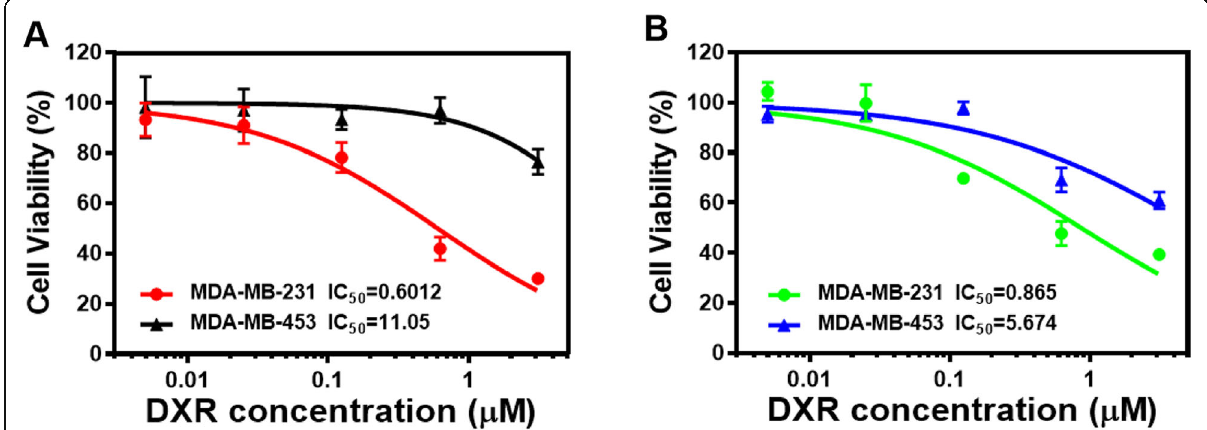
Fig. 7 In vitro cytotoxicity of NP-delivered drug vs free drug. Cytotoxicity of PLV/DXR ( a ) and free DXR ( b ) against MDA-MB-231 and MDA-MB-453